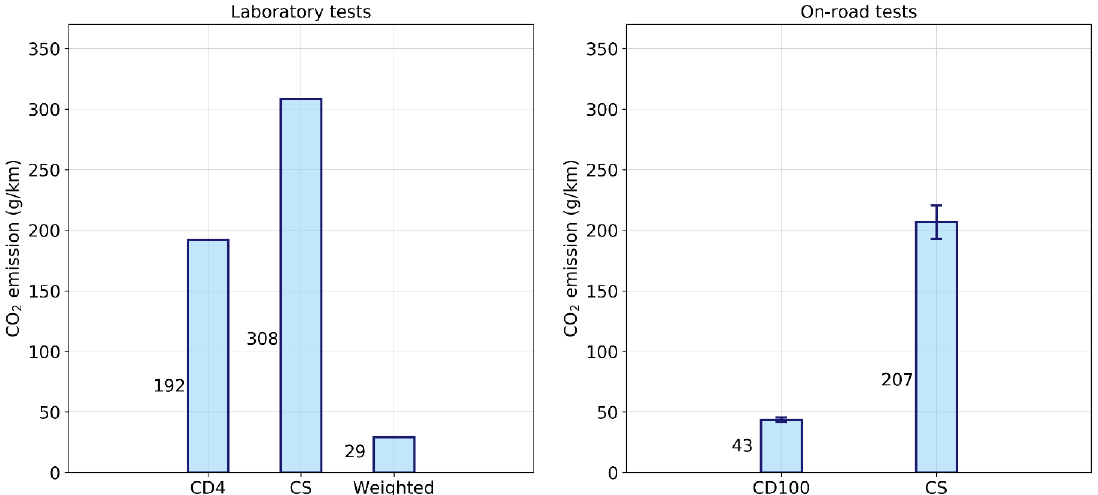
Figure 9. CO 2 emissions on laboratory and on-road tests performed according to the WLTP and RDE test procedures, respectively. For laboratory tests, CD4 indicates the 4th cycle in the charge depleting sequence (i.e., the cycle in which the ICE ignited for the first time). For on-road tests, CD100 indicates tests with an initial state of charge (SOC) equal to 100%. In both cases, CS indicates tests with an initial state of charge (SOC) equal to the minimum. Error bars on the graph represent max- imum and minimum values for conditions having more than one test. See Methods section for ad- ditional details.